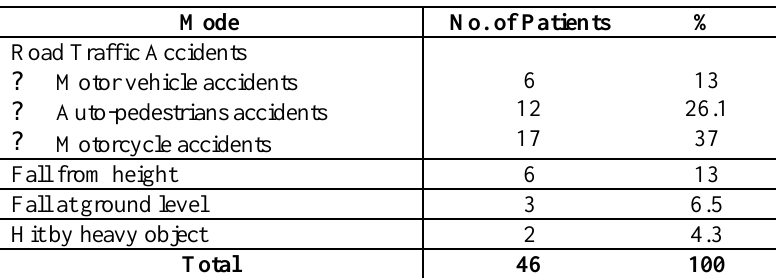
Table I : Mode of Injury